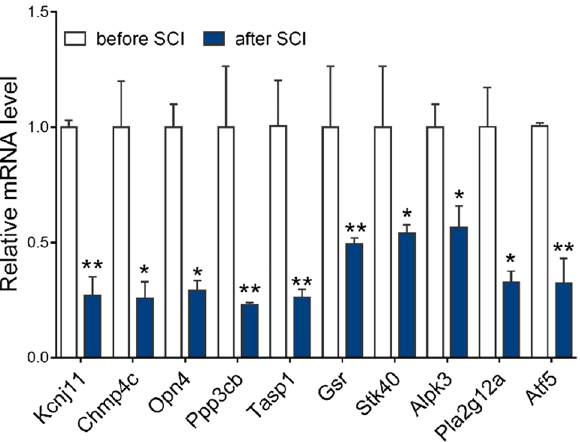
Figure 5. Verification using the mRNA expression. Kcnj11 , Chmp4c , Opn4 , Ppp3cb , Tasp1 , Gsr , Stk40 , Alpk3 , Pla2g12a , and Atf5 expression in before SCI (n = 6) and after SCI (n = 6) were evaluated by qPCR and normalised against the corresponding glyceraldehyde-3-phosphate dehydrogenase ( GAPDH ) expression. An asterisk represents p < 0.05 and two asterisks indicate p < 0.01 when compared with the before SCI